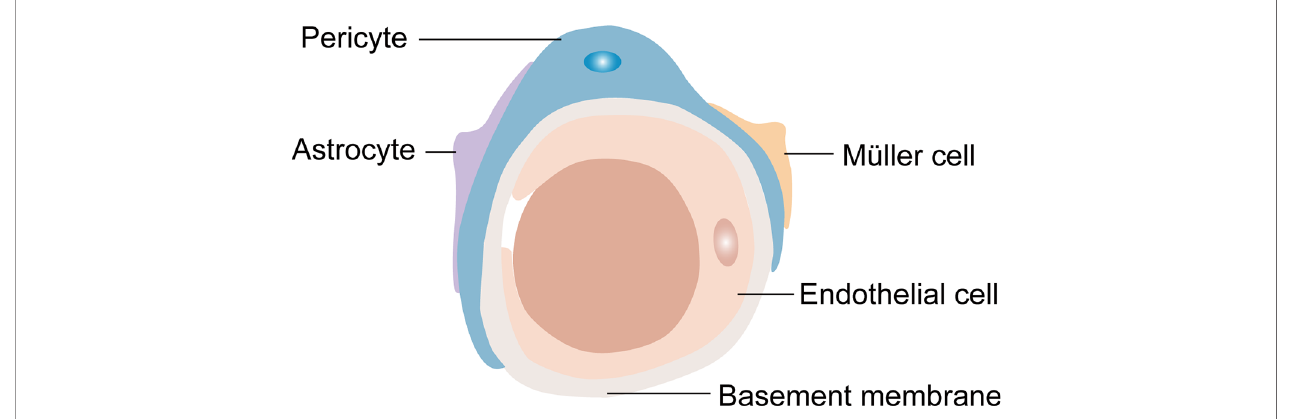
FIGURE 2 | The composition of the internal blood retina barrier (iBRB). Pericytes, endfeet of astrocytes and Müller cells cover the endothelial cells to form